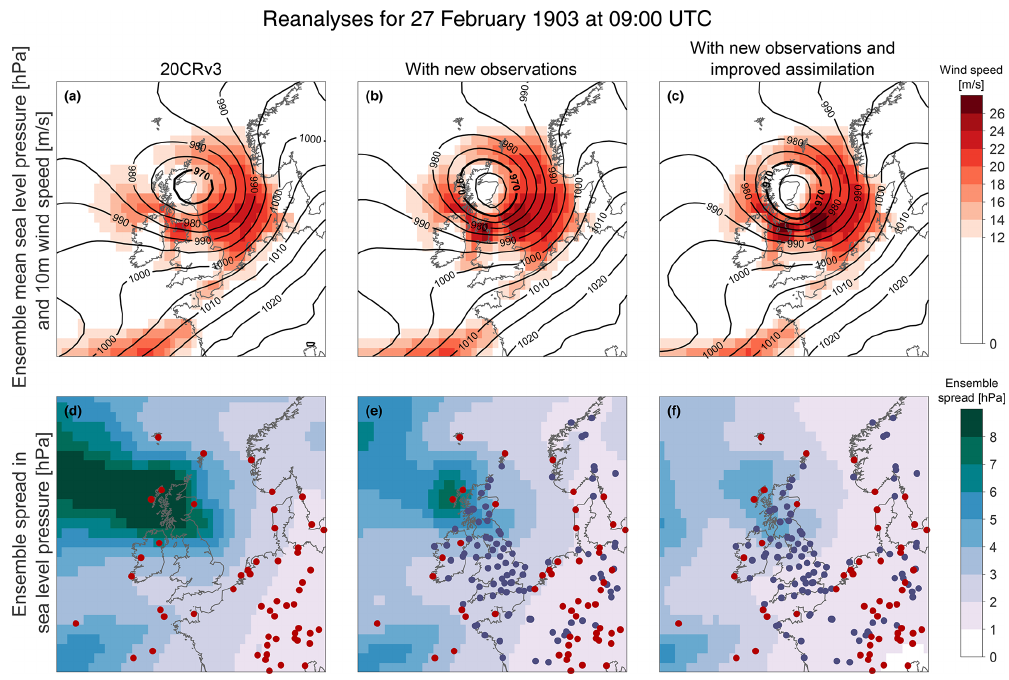
Figure 3. Reconstructing the atmospheric circulation during Storm Ulysses. Synoptic situation at 09:00UTC on 27 February 1903. Isobars of sea level pressure (hPa, black contours) and wind strength at 10m (ms − 1 , red shading) from the ensemble mean of 80 reanalysis fields are shown from 20CRv3 and the two different experiments (top row, a–c ). Standard deviation of the ensemble of sea level pressure reanalysis fields (“ensemble spread”) for the same time (hPa, blue shading, bottom row, d–f ). Locations with available surface pressure observations in 20CRv3 are shown as red dots, and new added observations in the experiments are shown as dark blue dots. Observations from both land stations and ships are shown, but there are very few available ship observations in this region at this